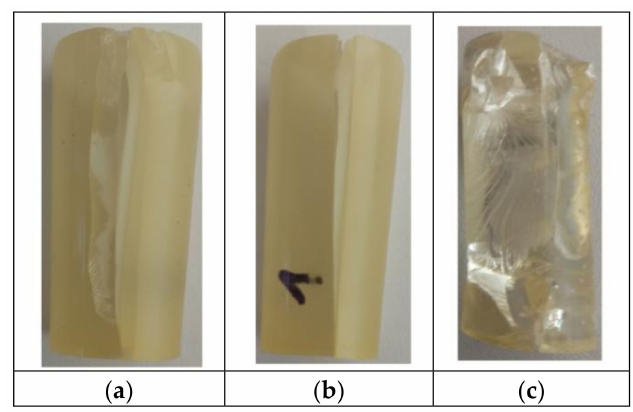
Figure 3. Forms of failure of the compressed modified epoxy compound samples: ( a ) cracking, ( b ) buckling and cracking, and unmodified epoxy compound’s sample; ( c ) spalling.